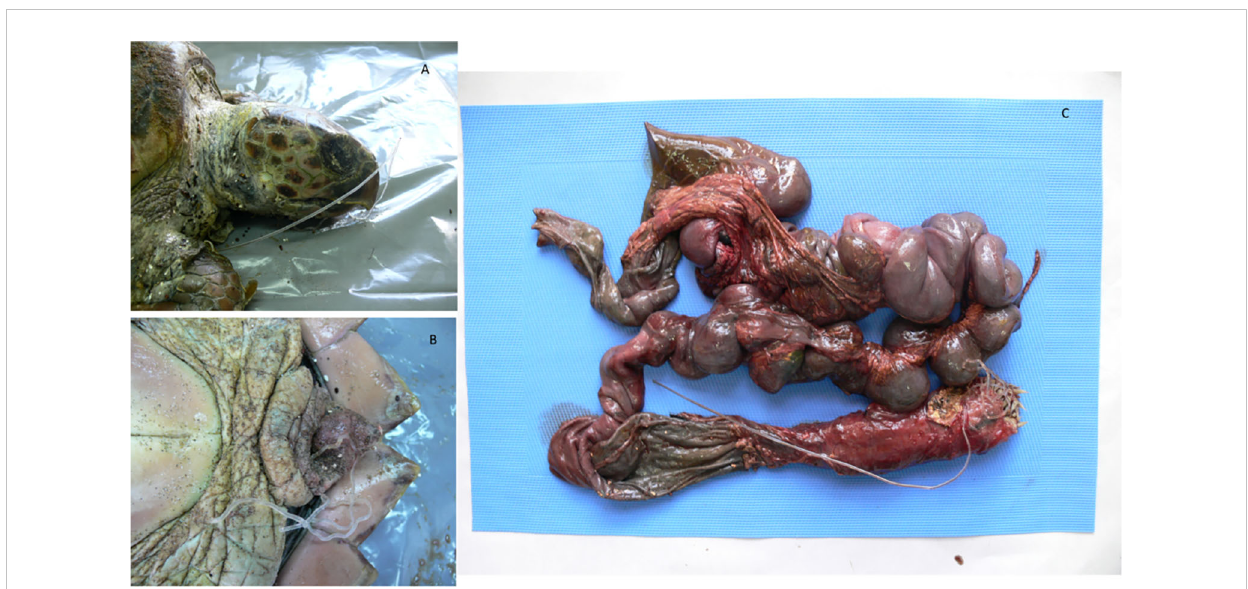
FIGURE 2 Loggerhead sea turtle that ingested a line. The object entered the rhamphotheca (A) and exited the cloaca, (B) causing plication and intussusception in both small and large tracts of the intestine (C)